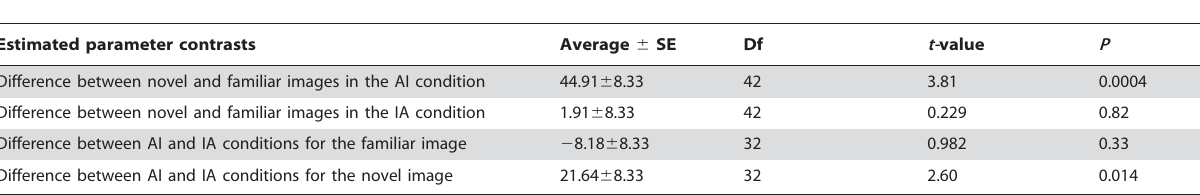
Table 1. GLMM parameter estimate coefficients in Experiment 1.